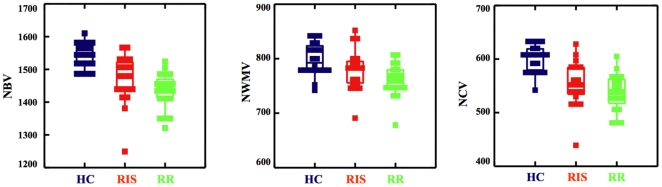
Brain volumes in HC, RIS and RRMS.Box plots comparing the brain volumes of HC (left), RIS subjects (center) and RRMS patients (right). Values are relative to NBV (left), NWMV (center) and NCV (right). Note the presence of similarly low values of brain volume in RIS subjects and RRMS patients with respect to HC. See text for abbreviations.